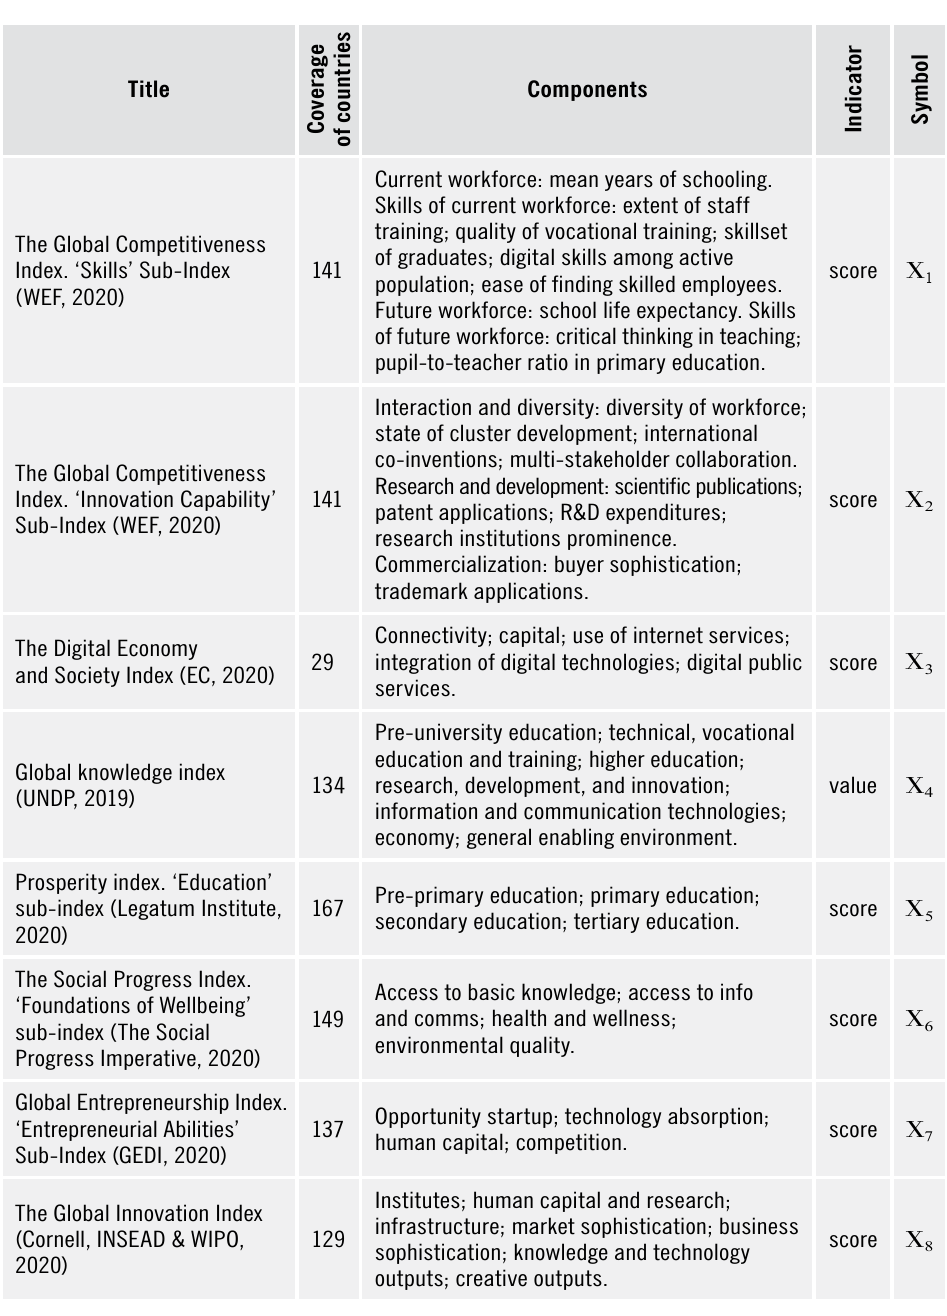
Table 1. International indices and sub-indices containing components of knowledge